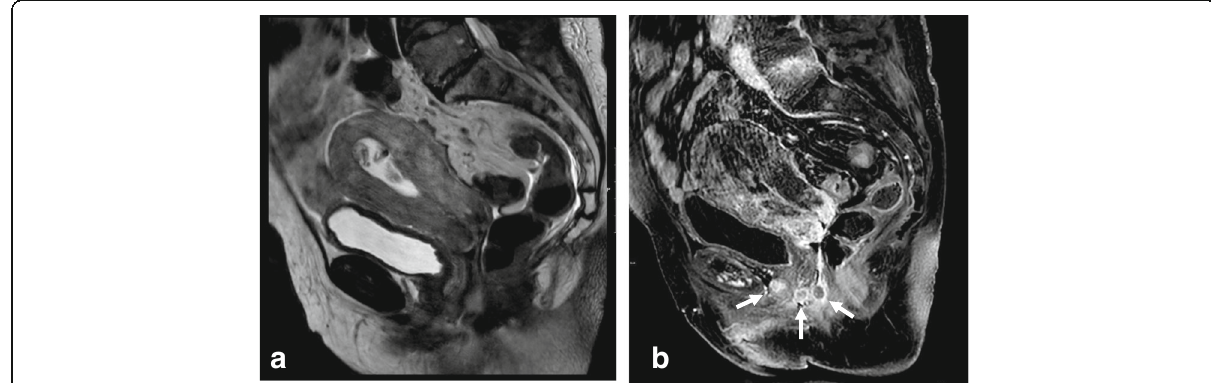
Fig. 9 Small cell neuroendocrine tumor with myometrium and cervical invasion visualized by sagittal T2WI ( a ) and sagittal DCE ( b ). Vaginal and pubic metastasis are much better delineated in the DCE sequence